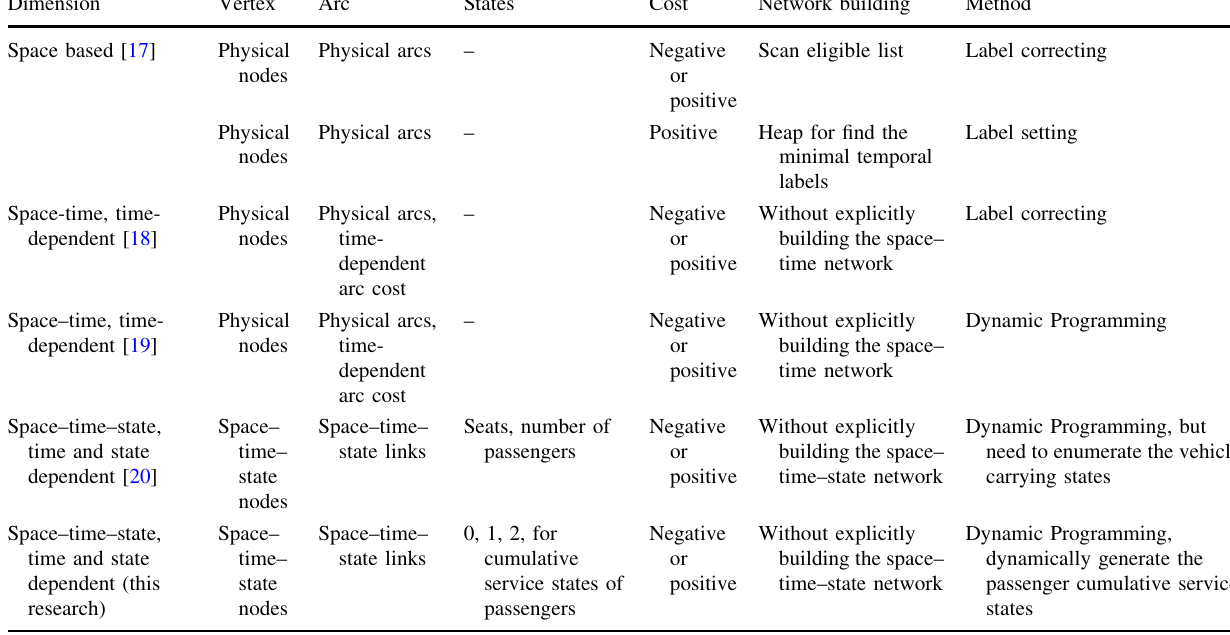
Table 1 Comparison of different shortest path algorithms (network representation, arc cost, data structure, and solution methods)